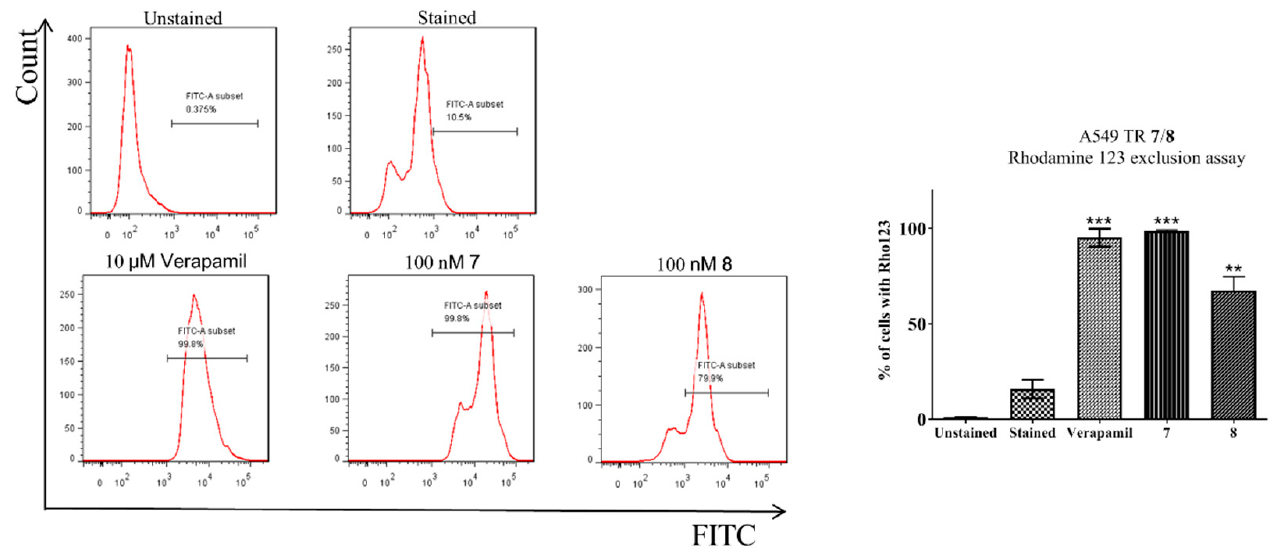
Figure 3. The intracellular level of rhodamine 123 accumulation in taxol-resistant A549 cells acquired by flow cytometry analysis. Cells were treated with 5 µ M of rhodamine 123 for 1 h at 37 ◦ C along with 10 µ M of verapamil (positive control), 100 nM of 7 or 8 . Control sample (arbitrarily set as 100%) was acquired without any compound treatment. Data are expressed as % of rhodamine 123 accumulation (** p < 0.01, *** p < 0.001).